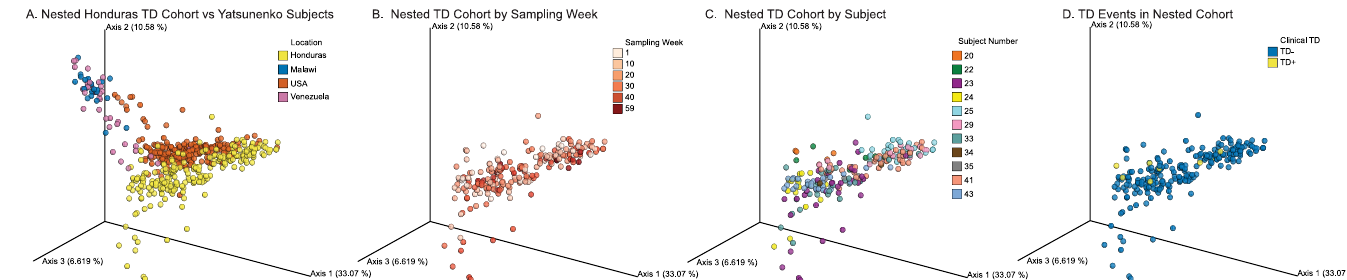
Fig 6. PCoA of study 2b subjects deployed to Honduras. Samples are shown in a principal coordinate plot, clustered by weighted UniFrac distances, with the axis numbers showing the percentage variation explained by that axis. A) Samples from the current study compared to samples from other locations (Yatsunenko et al [41]). Samples are colorized by geographic location. B) Samples from the study 2b are shown in a time gradient (week of sampling; week 1 indicates the first week of overseas deployment). C) All samples from each subject in study 2b are colorized by individual. D) The specific time points of TD incidents in the study 2b are highlighted. See also S2